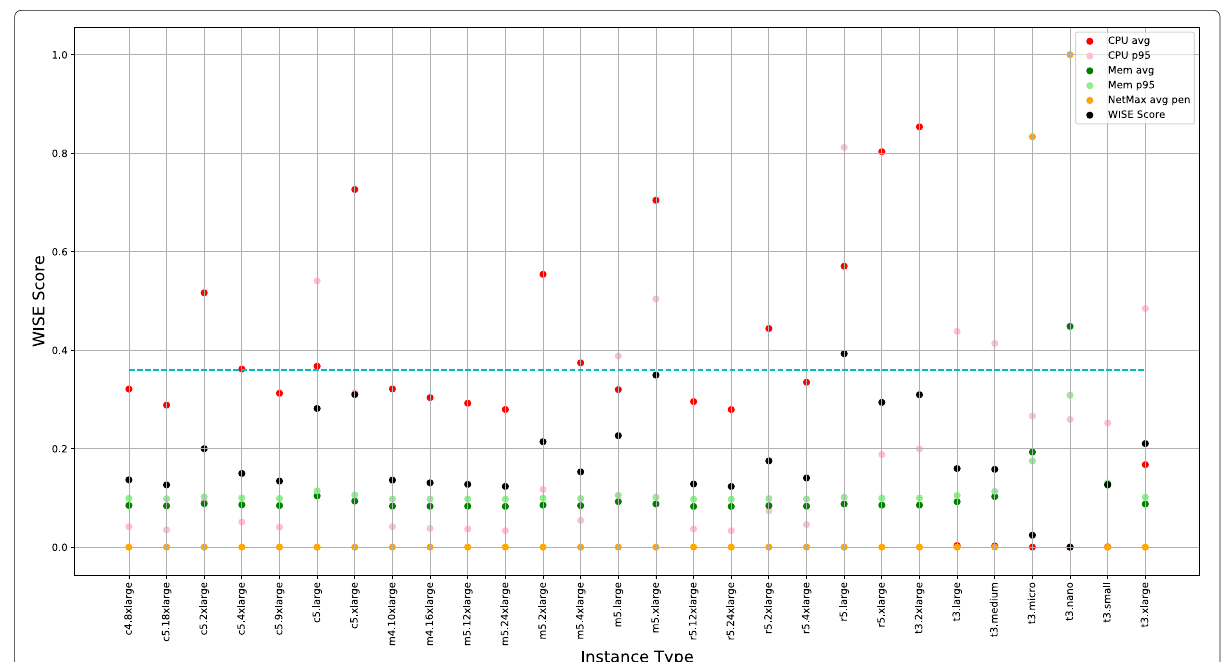
Fig. 6 WISE scores using the exponentially monotone function and (cid:4) 1 -norm for MongoDB Workload